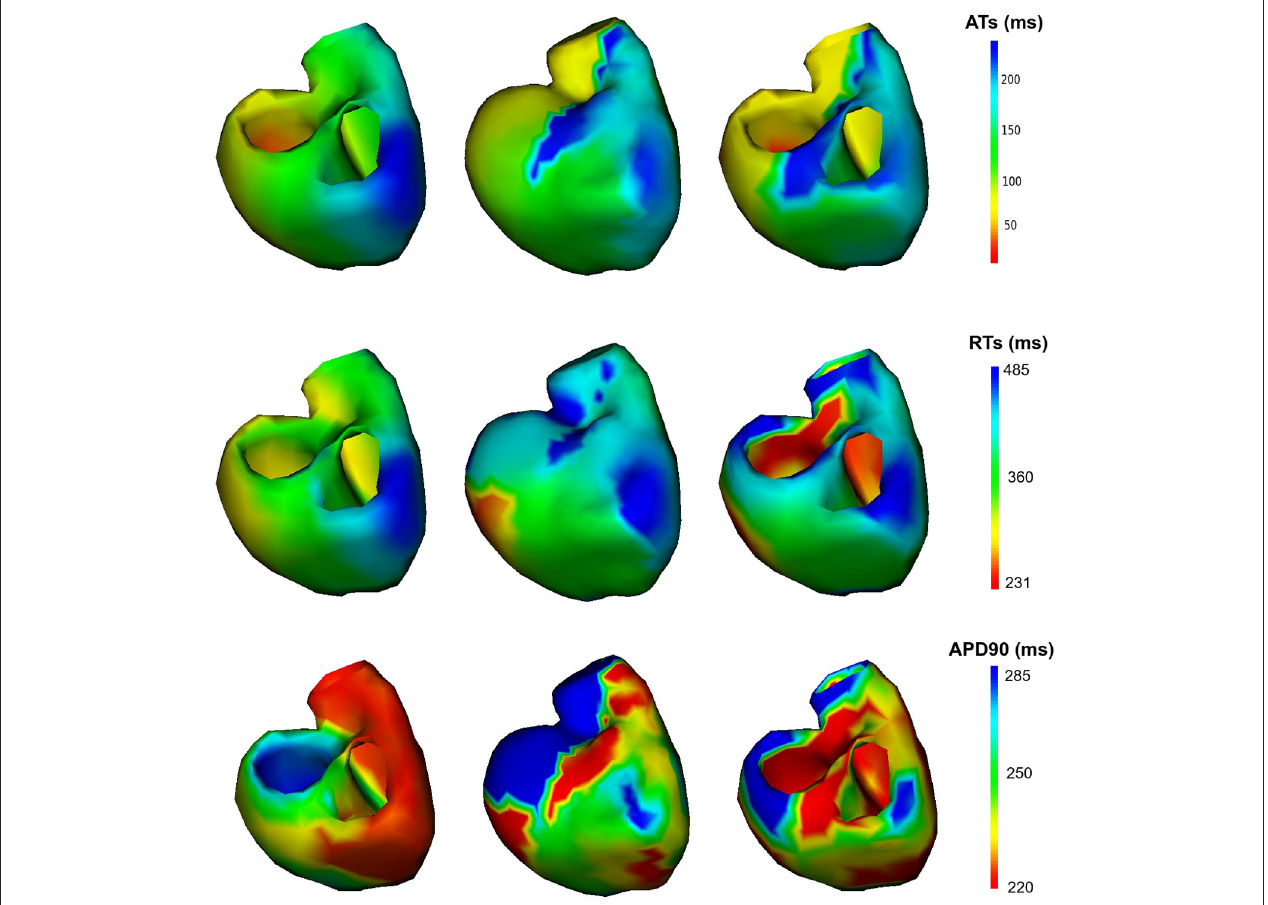
FIGURE 4 | Activation, repolarization and APD90 maps of the RV pacing case. Left : reference ATs; middle : optimized ATs from Mesh1 ; right : optimized ATs from Mesh2 . Right posterior oblique view.